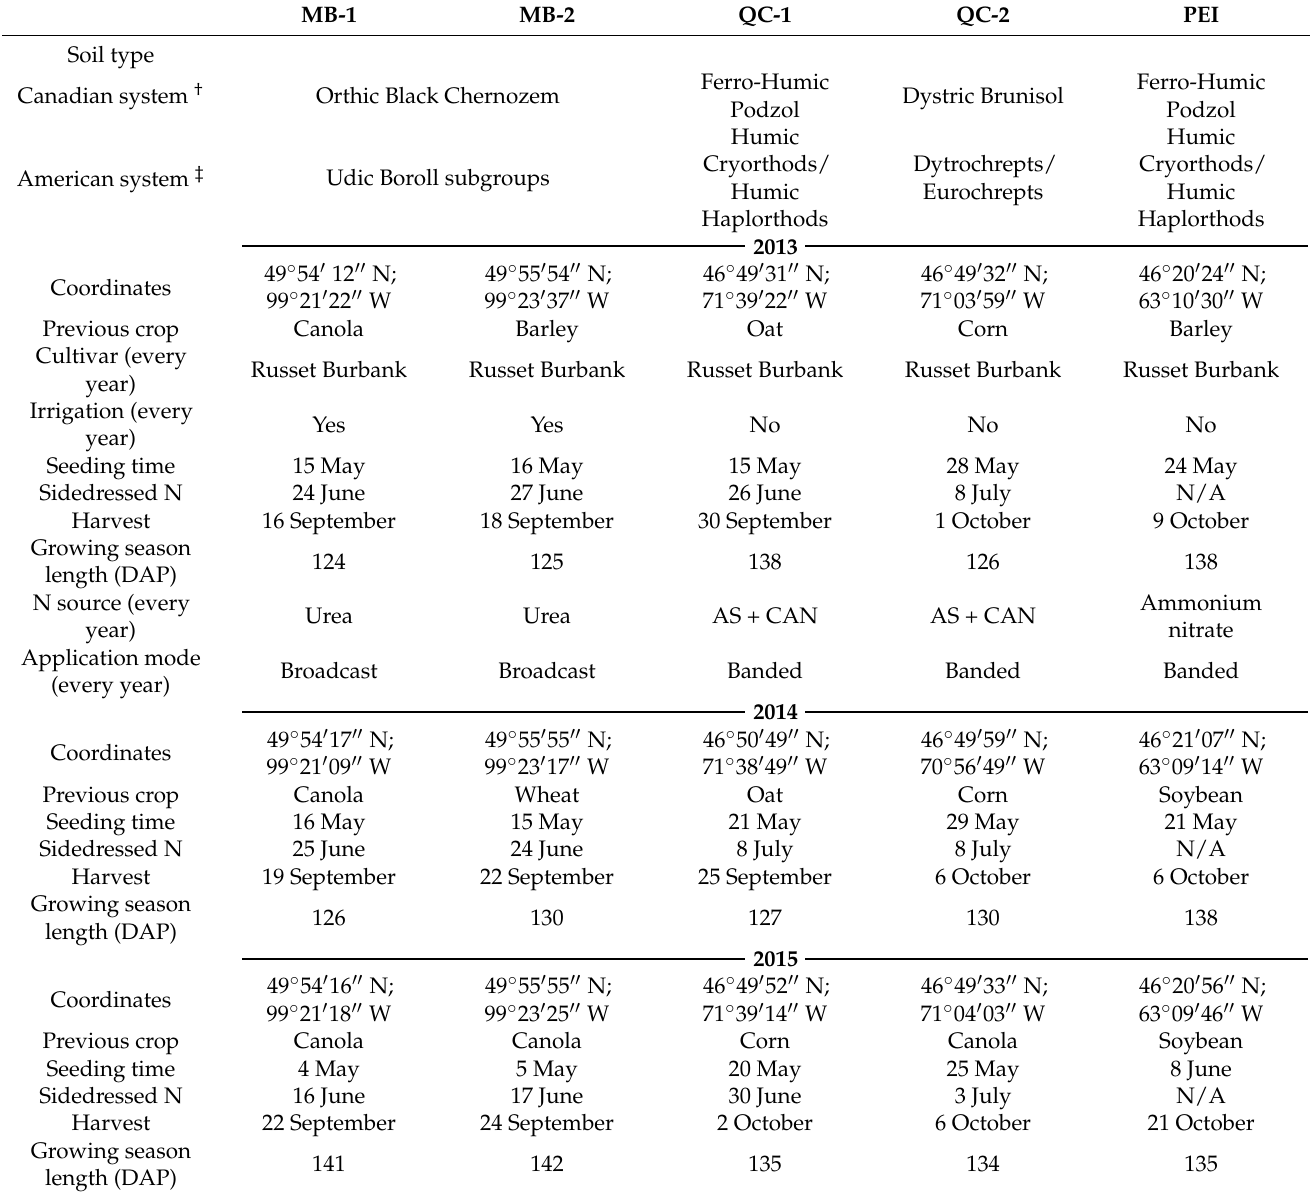
Table 1. Site characteristics and cropping practices.